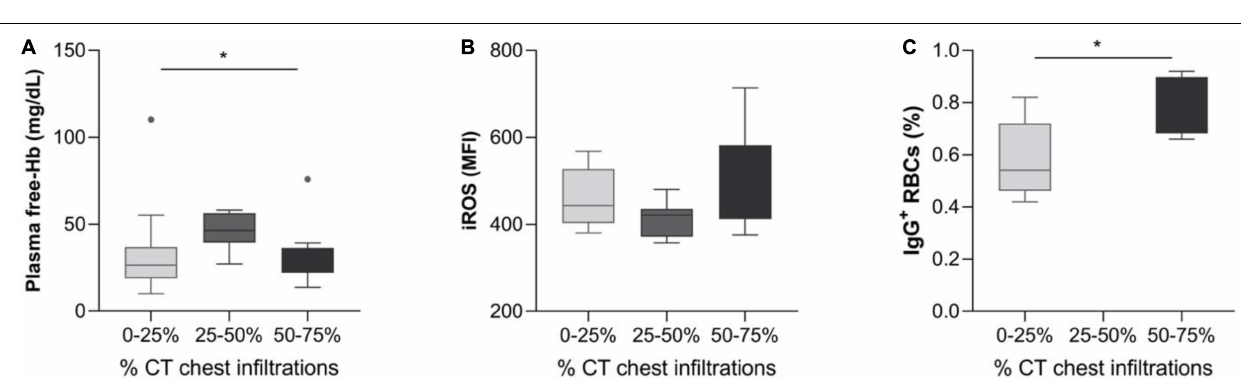
[443 (403–527) vs. 421 (371–425) vs. 535 (412–582)